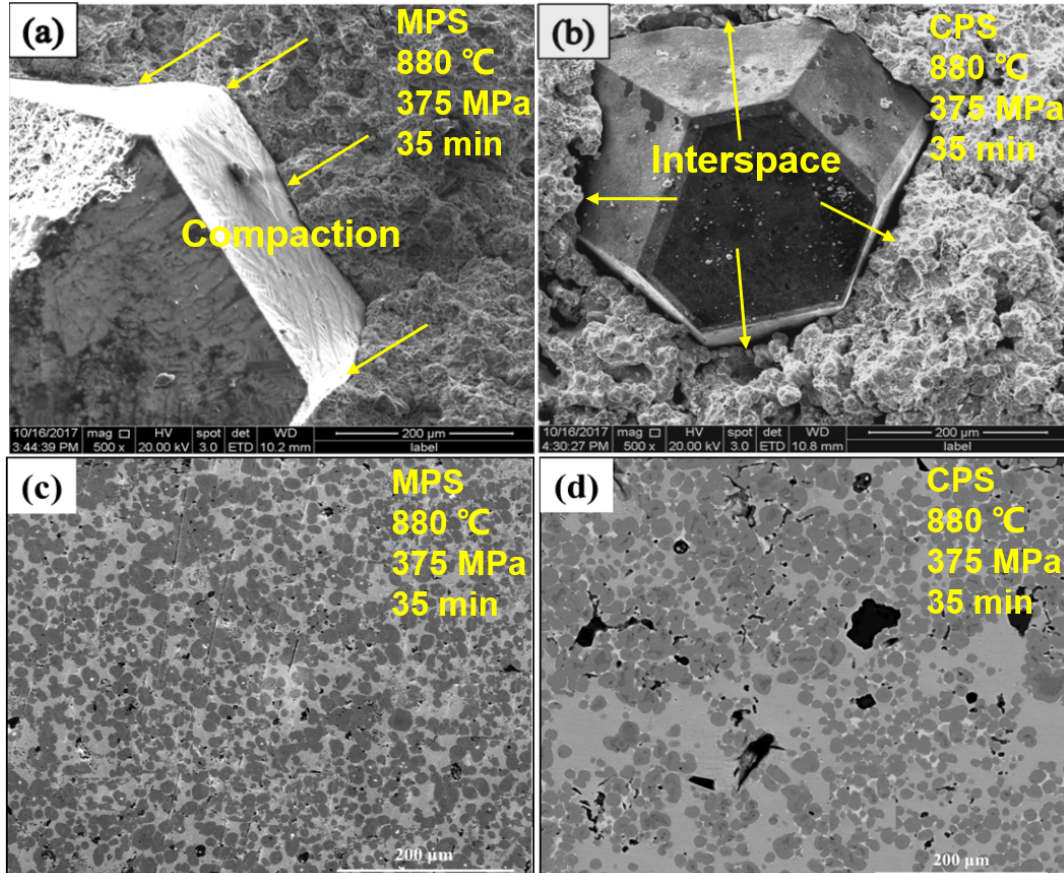
Figure 8. Backscattered scanning electron microscopy (BSE-SEM) pictures of microstructure morphology of samples sintered by microwave ( a , c ) and conventional sintering ( b , d ).